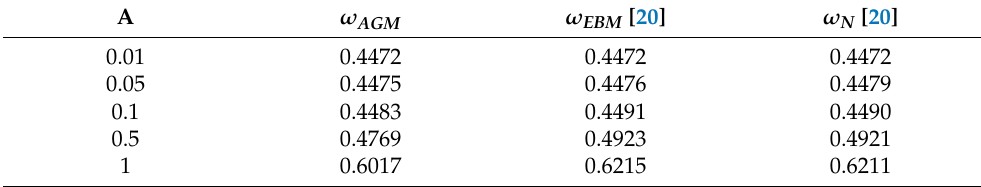
Table 2. Comparison between AGM, EBM and exact numerical solution for mode 1 in Table 1 ( λ =